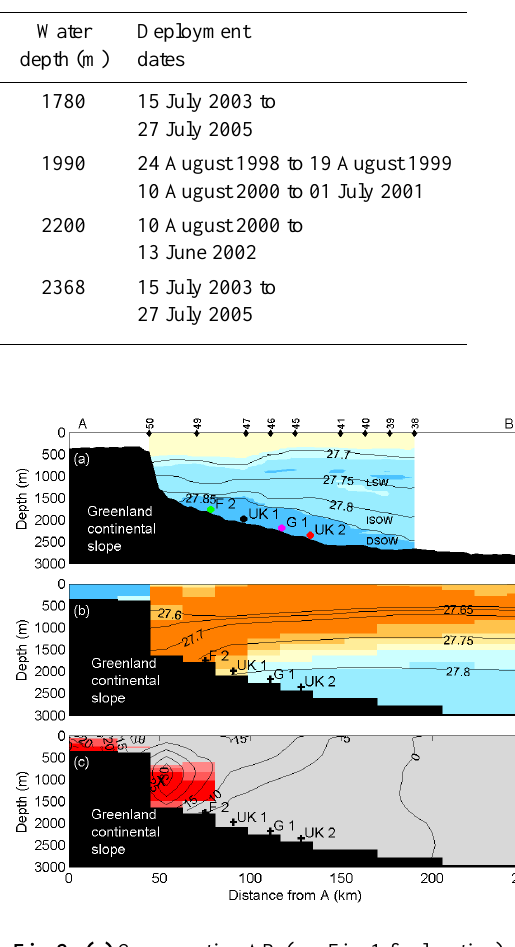
Fig. 2. (a) Cross-section AB (see Fig. 1 for location) showing locations of moorings F2, UK1, G1 and UK2, at the depths at which salinity measurements were obtained. Contours and shading represent σ θ and salinity respectively, obtained from CTD casts during the June 2009 MSM 12-1 cruise. Numbers along top indicate CTD deployments. (b) Section through the Angmagssalik moorings in OCCAM, showing the mean June salinity between 1994 and 2004. Contours indicate the 11-year mean of OCCAM σ θ . (c) Section through the Angmagssalik moorings in OCCAM, showing the correlation coefficient between mooring UK1 salinity anomaly time series and the equivalent OCCAM salinity anomaly time series in each grid cell (p < 0.01). Contours indicate the 11-year mean of OCCAM current velocity (cm s -1 ) normal to section AB (positive values indicate southwestward flow). Grey indicates no statistically significant correlation.